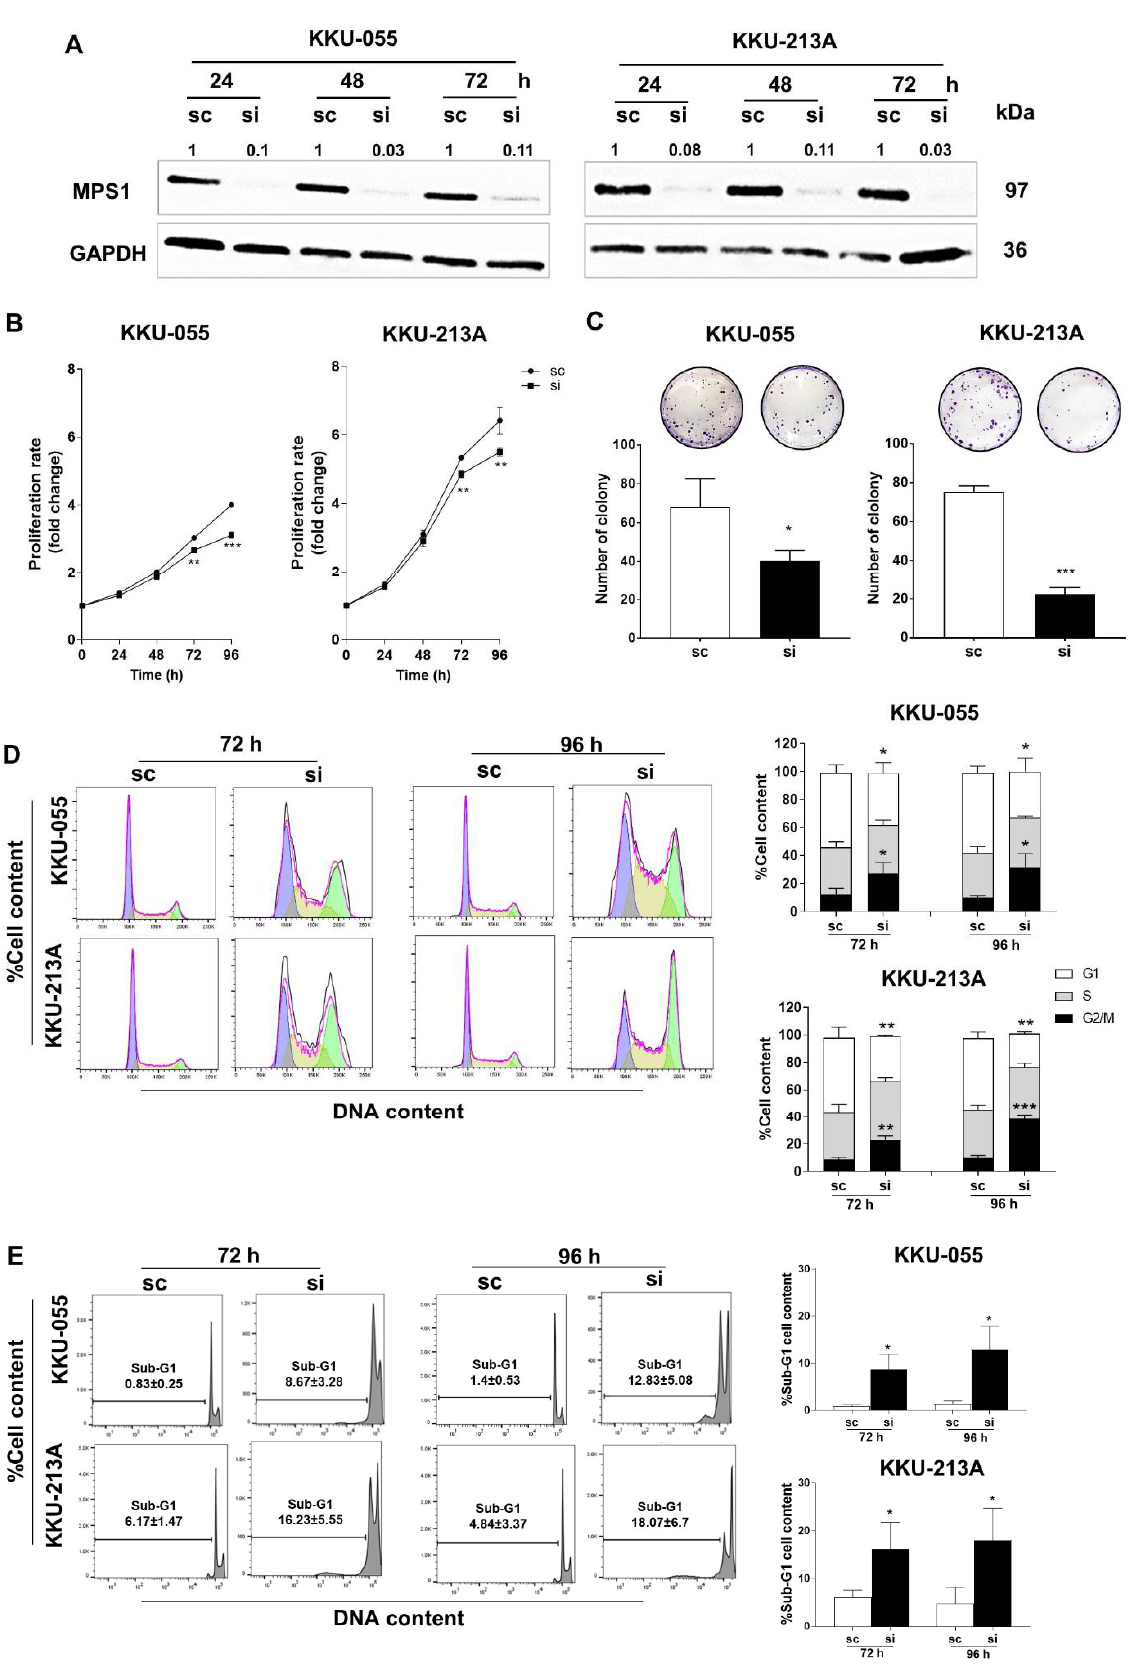
Figure 3. MPS1 contributed to cell proliferation, colony formation, and altered cell cycle of CCA cell lines. ( A ) Knockdown efficiency of MPS1 specific siRNA at 24 to 72 h in KKU-055 and KKU-213A cell lines. Quantification of each band was normalized to GAPDH and is shown as the numbers above the corresponding panels. ( B ) Cell proliferation rates of siMPS1